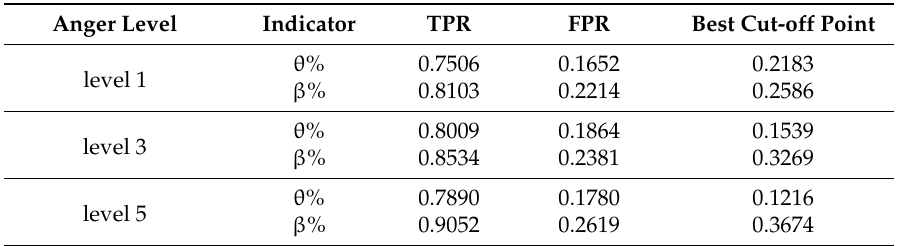
Table 3. Best cut-off point (optimal threshold) for indicator θ % and β % at different anger